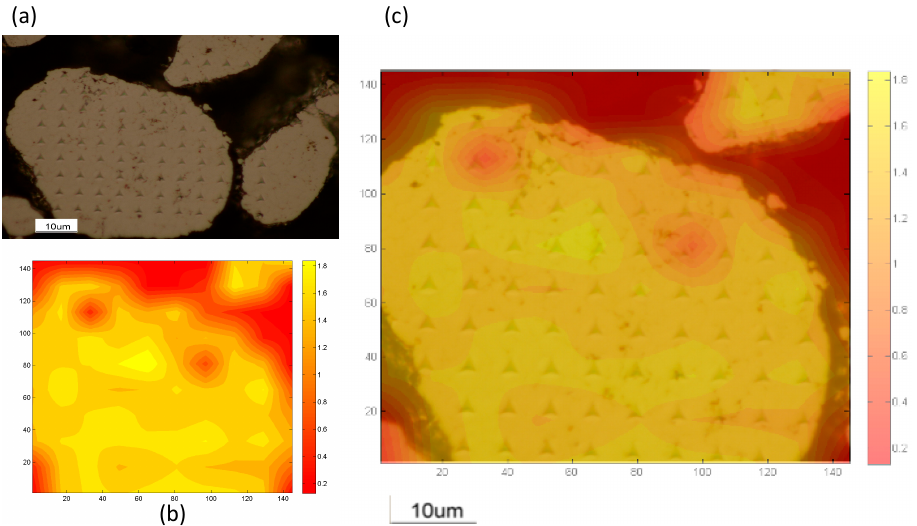
Figure 43. ( a ) Optical micrograph of mounted Al 6061 gas-atomized feedstock embedded in an epoxy and characterized using nanoindentation mechanical mapping. ( b ) Resultant contour plot of hardness relative to the indentation grid and location-specific 2D data from ( a ). ( c ) Overlays the contour plot associated with ( b ) upon the micrograph in ( a ) for explicit microstructure-hardness comparison.